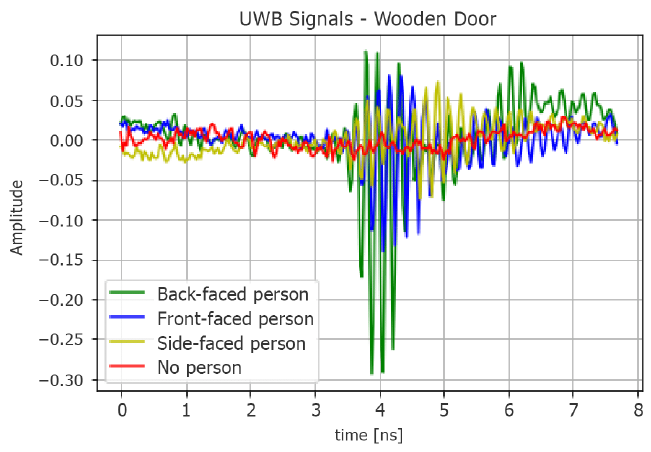
Figure 3. Example of time-domain pulses acquired in static condition.